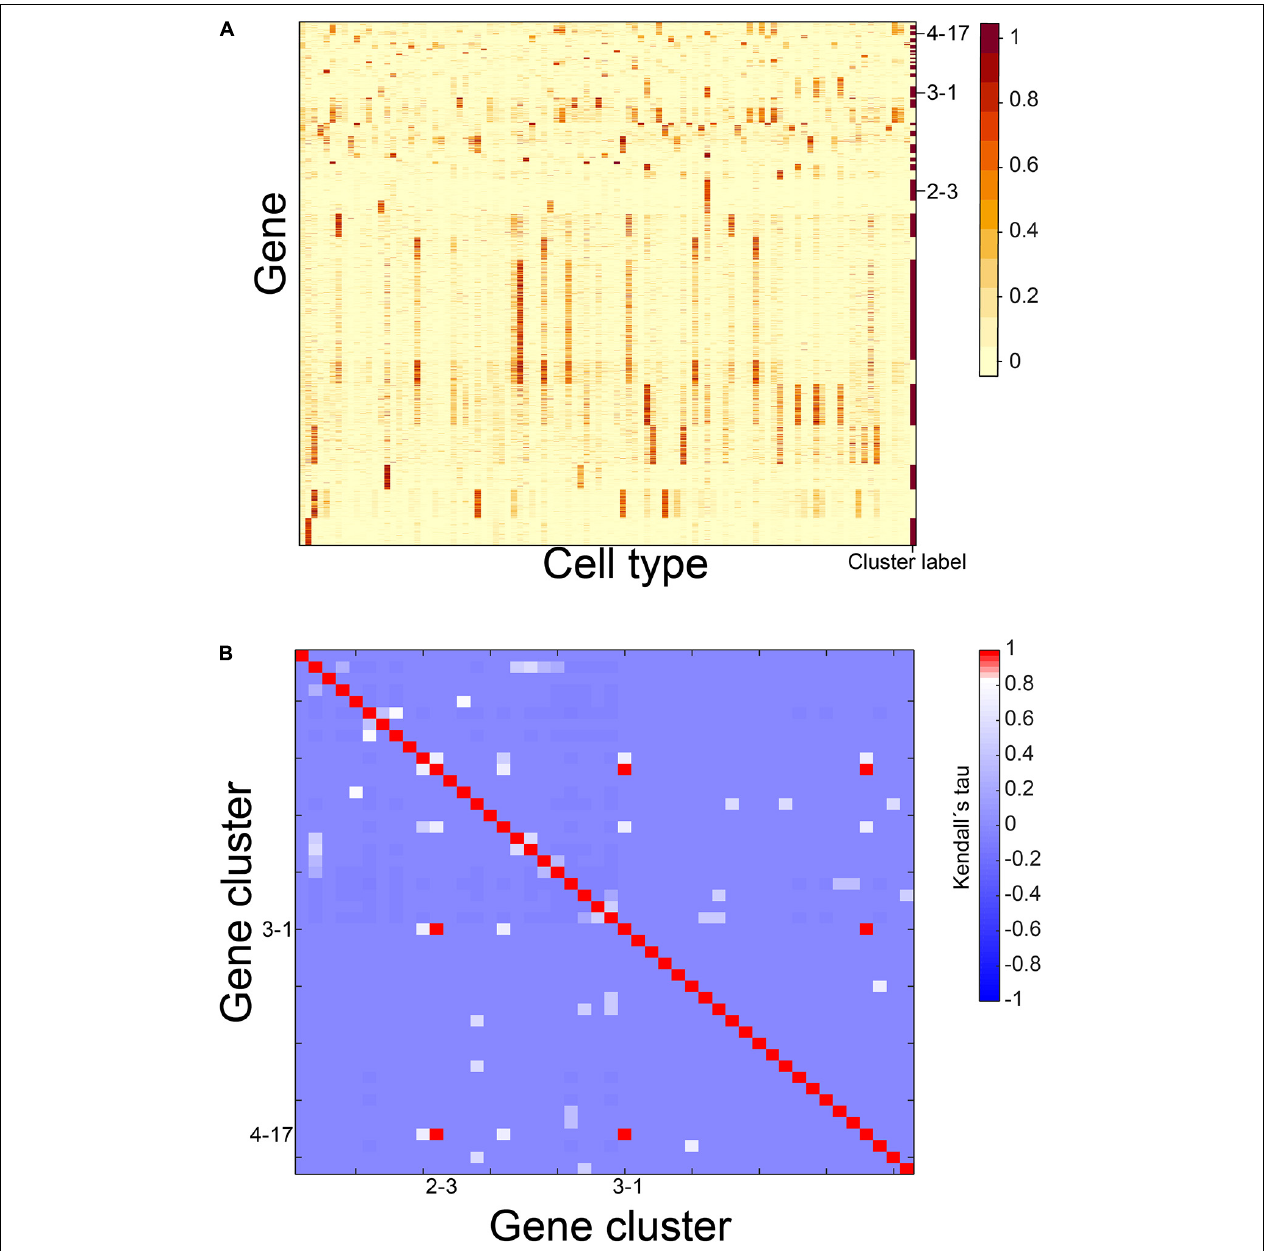
FIGURE 2 | Gene expression patterns of identified CTS gene clusters. (A) Expression heatmap of the 46 identified CTS gene clusters. (B) Heatmap of Kendall rank correlation coefficients between CTS gene cluster pairs. Genes in the heatmap were sorted by the gene clusters, and the “cluster label” distinguished the genes from different gene